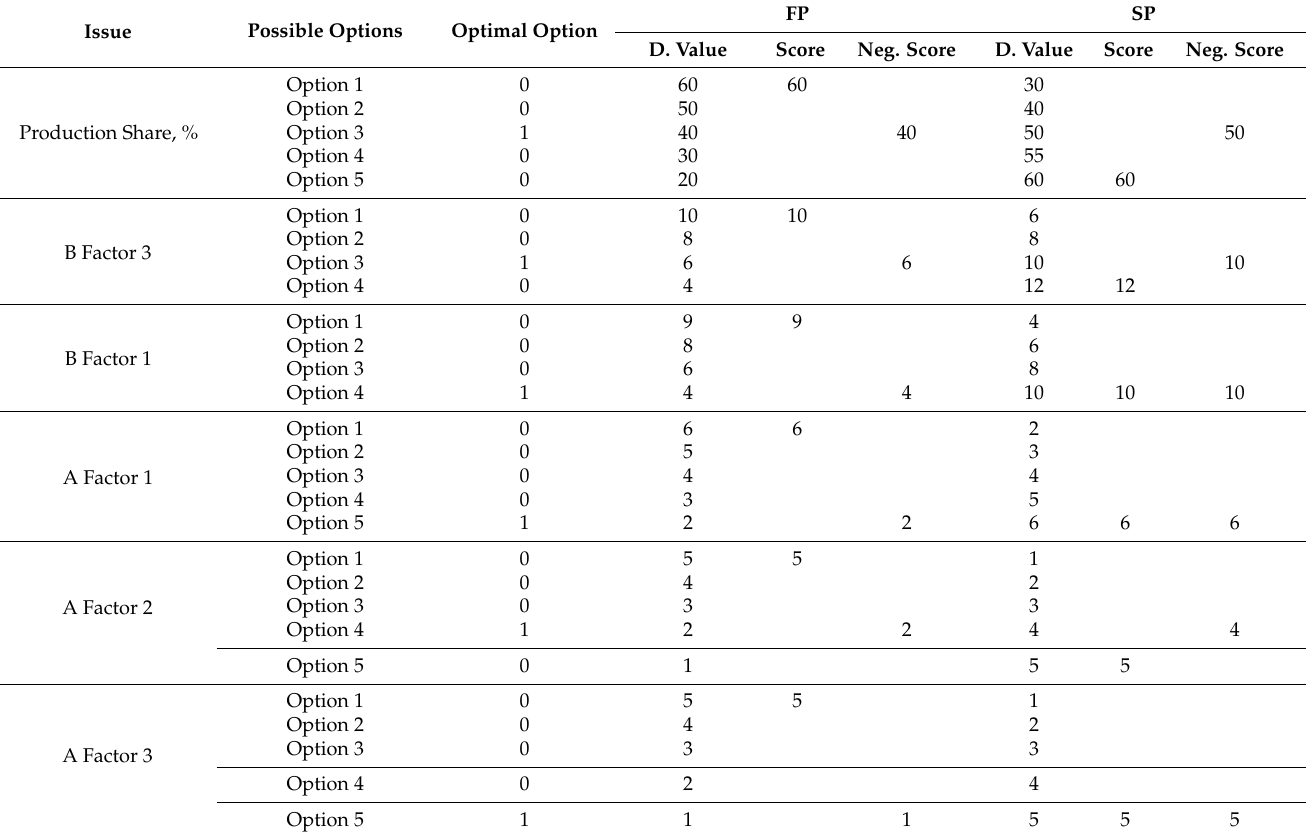
Table 7. Nash solution of the negotiation score of FP and SP from the Solver